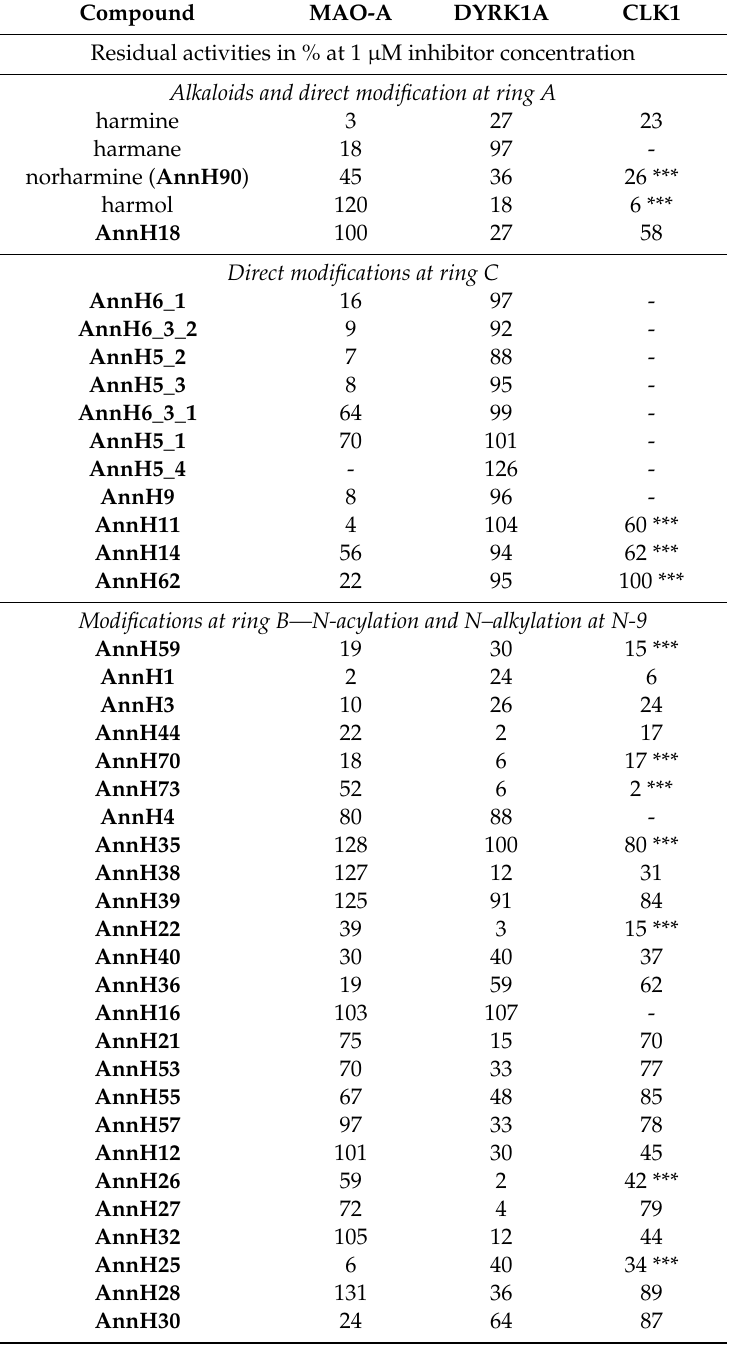
Table 1. Results of in vitro screening of the harmine analogues on MAO-A, DYRK1A and CLK1 1 . Compound MAO-A DYRK1A CLK1 Residual activities in % at 1 µ M inhibitor concentration Alkaloids and direct modification at ring A